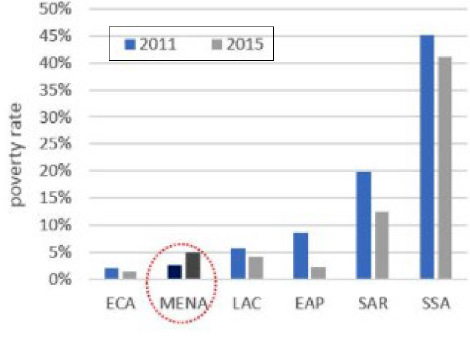
Figure 1. Extreme poverty rates at US$1.9 2011 ppp line cross regions in 2011 and 2015,